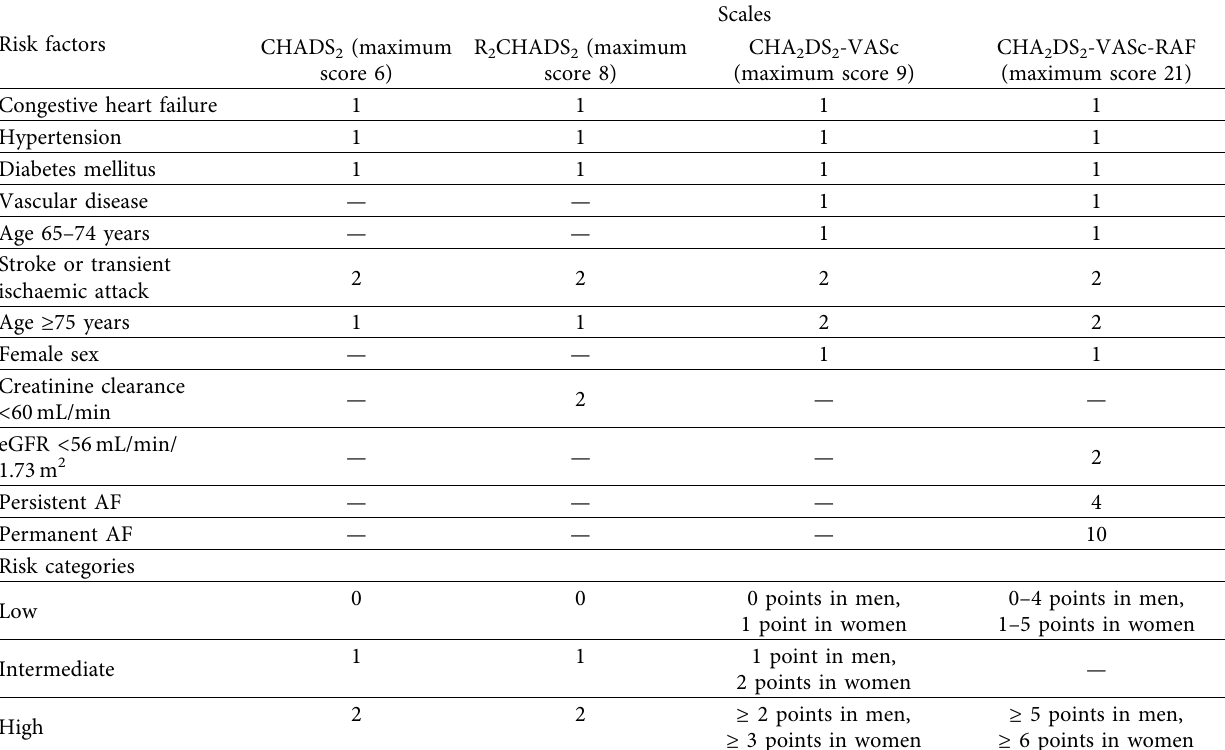
Table 1: Scales applied to estimate the risk of thromboembolic complications in patients with